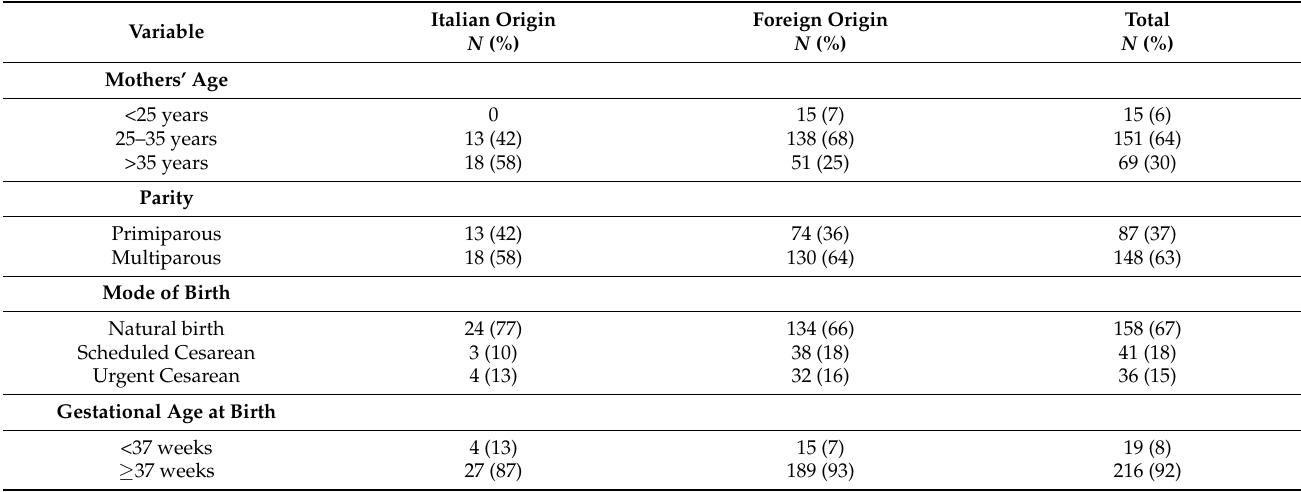
Table 1. Baseline characteristics of HBsAg positive women and their infants. Abbreviations: Kg = kilograms; mixed feeding = breastfeeding combined with bottle